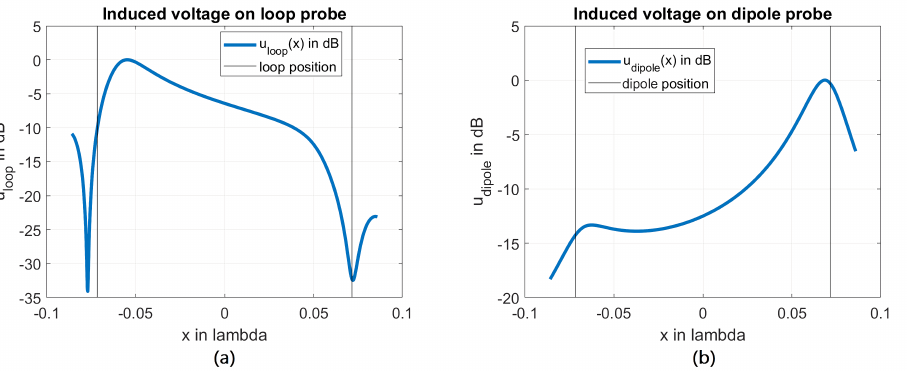
Figure 26. The induced voltage of a loop probe ( a ) and a dipole probe ( b ) when moved along the green line denoted in Figure 25 above a 0.05 λ loop